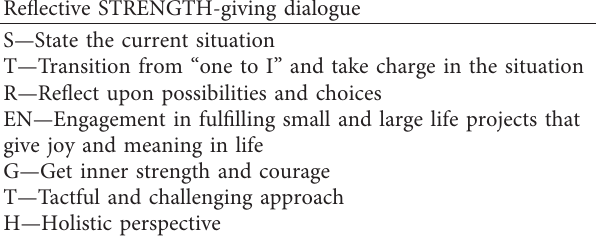
Table 1: Key dimensions of the reflective STRENGTH-giving